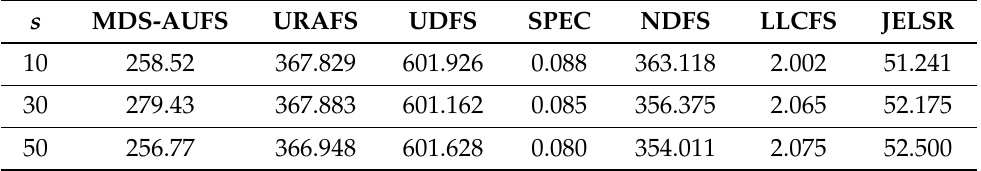
Table 6. The computation time of different methods on lung and leukemia datasets (unit: